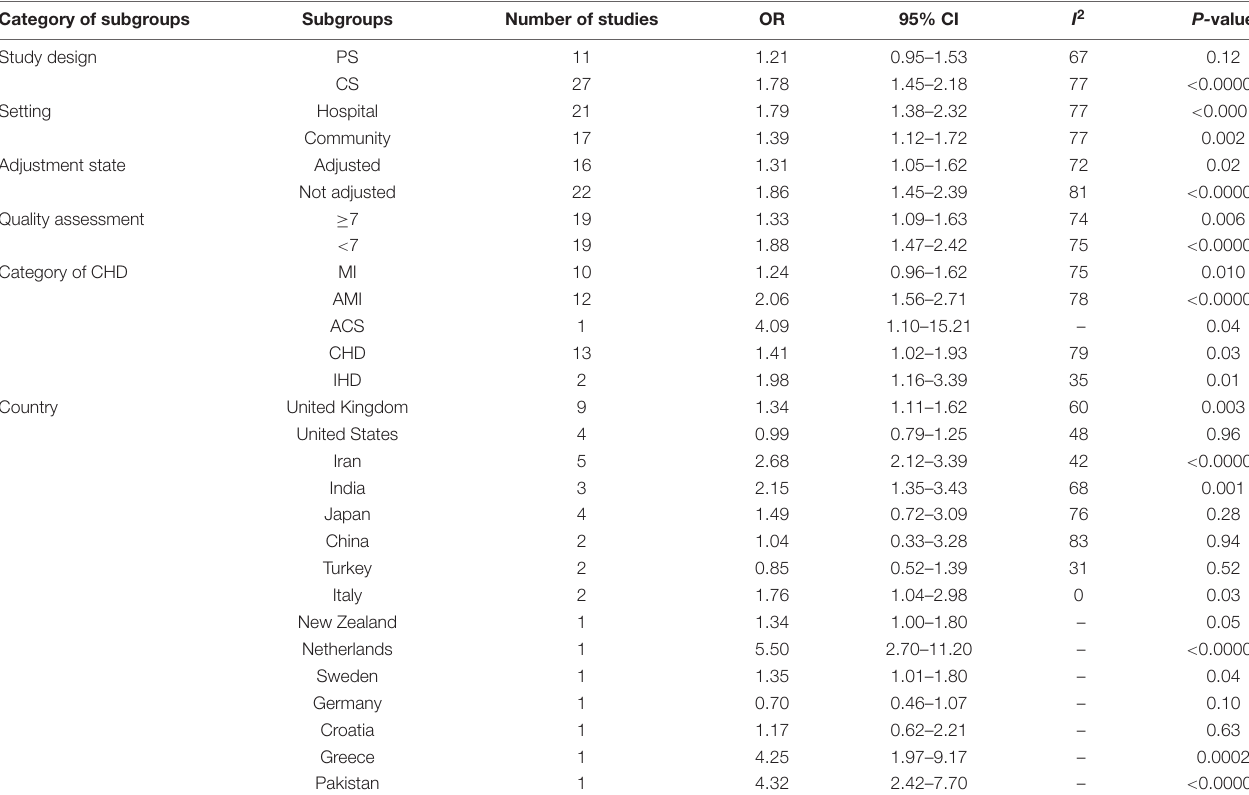
TABLE 2 | Subgroup analyses about between anti- H. pylori IgG and CHD.